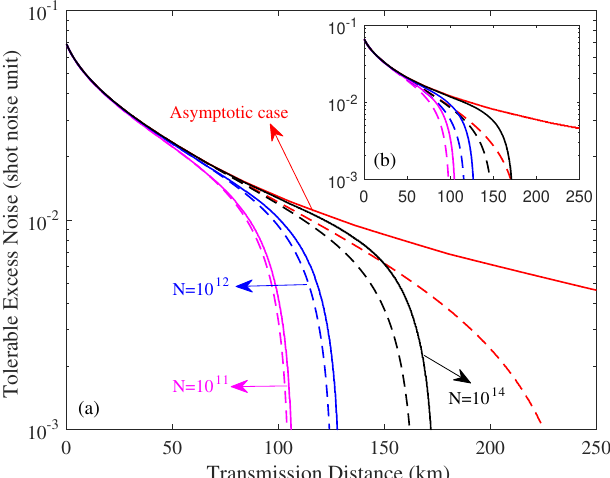
Figure 9. The maximal tolerable excess noise of CVQKD involving the ZPC operation (dotted lines and solid lines) for the traditional CVQKD (dotted lines) and the ZPC-based CVQKD (solid lines), where ( a ) represents eight-state DM source preparation, and inset ( b ) represents four-state DM source preparation.